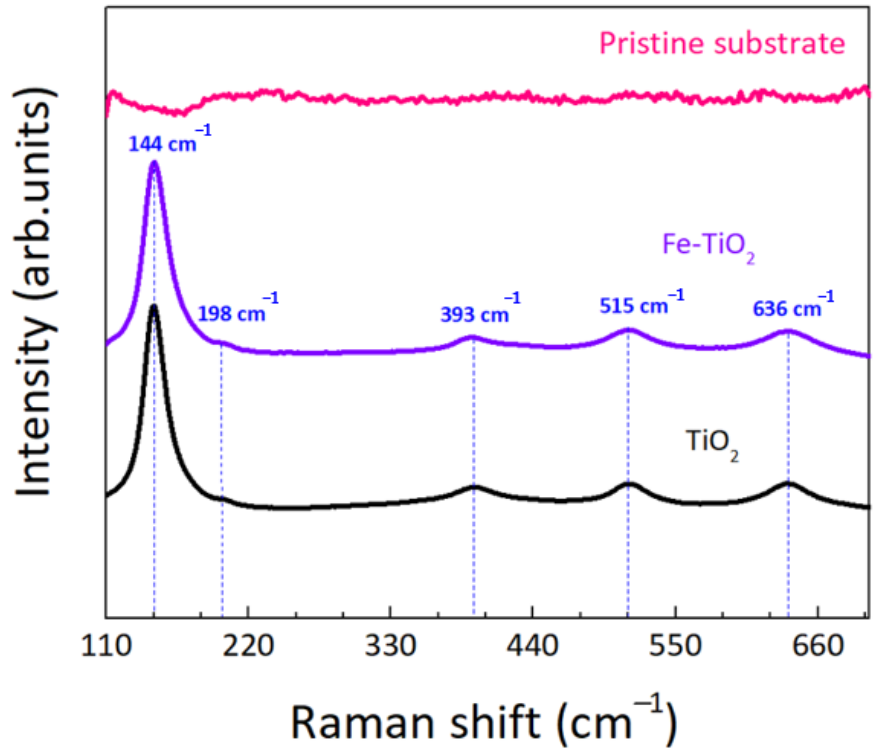
Figure 9. Raman spectra of the pristine polymeric substrate, TiO 2 and Fe-TiO 2 nanopowders impregnated on the polymeric substrates. Vertical dotted lines represent anatase TiO 2 bands.